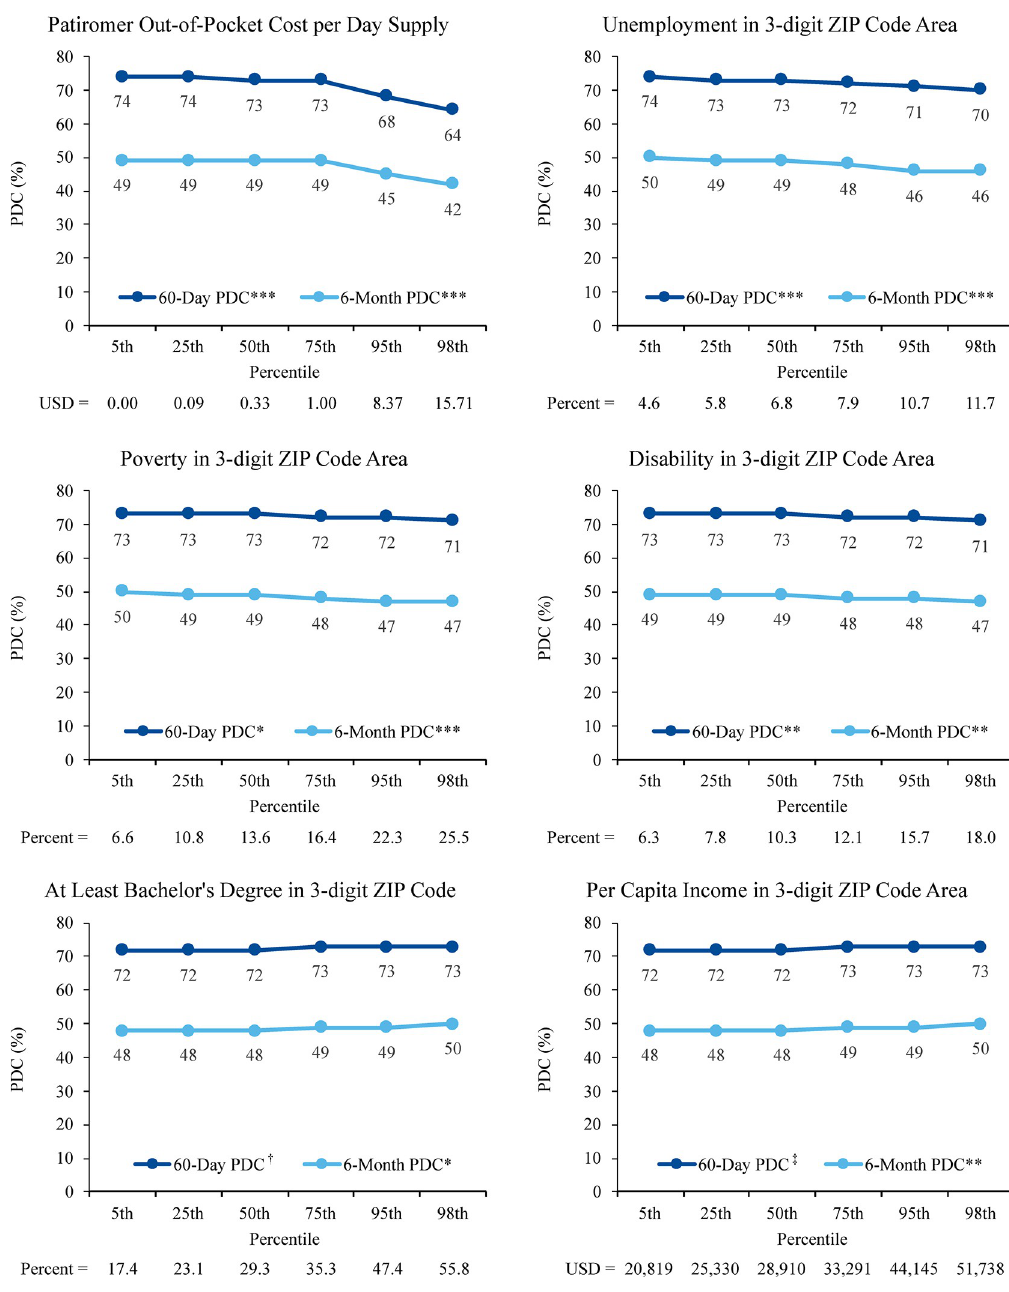
Fig 2. 60-day and 6-month regression-adjusted PDC for continuous independent variables. ��� p < 0.001; �� p < 0.01; � p < 0.05; † p = 0.11; ‡ p = 0.17. Abbreviations: PDC, proportion of days covered; USD, United States